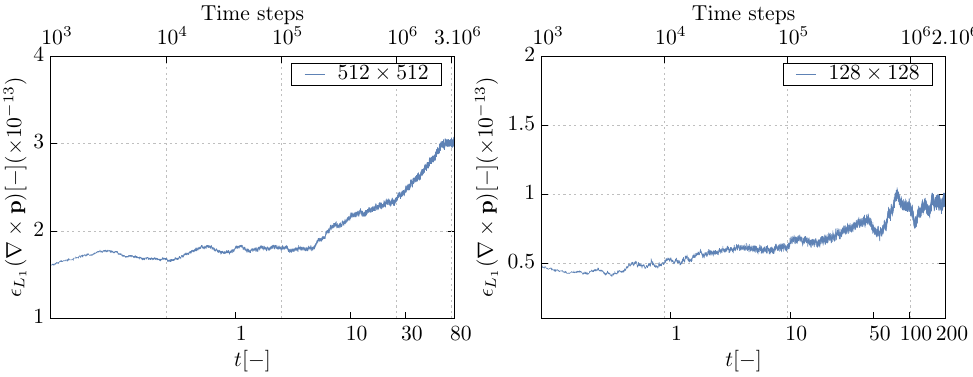
Figure 7. Long-term evolution of the discrete curl errors, for the non-condensing bubble test case. The left figure corresponds to a simulation with a 512 128 128 grid. The model parameters taken here are the same as in Figure 6. The upper horizontal × axis indicates the number of time steps, while the lower axis reports the time t